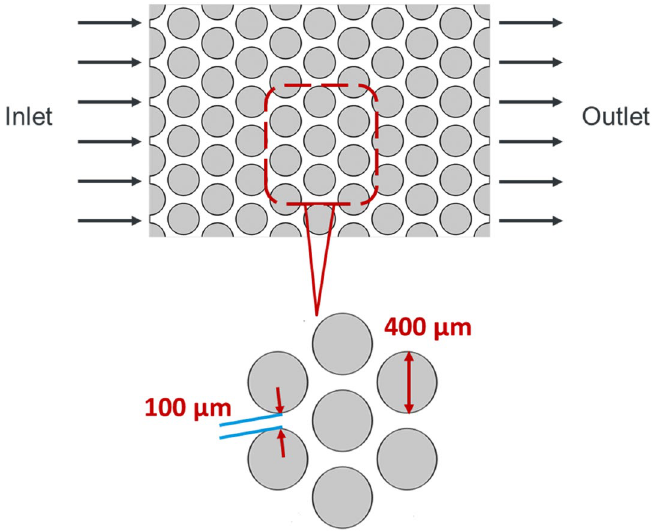
Figure 2. Representation of the geometry of the porous medium studied in this